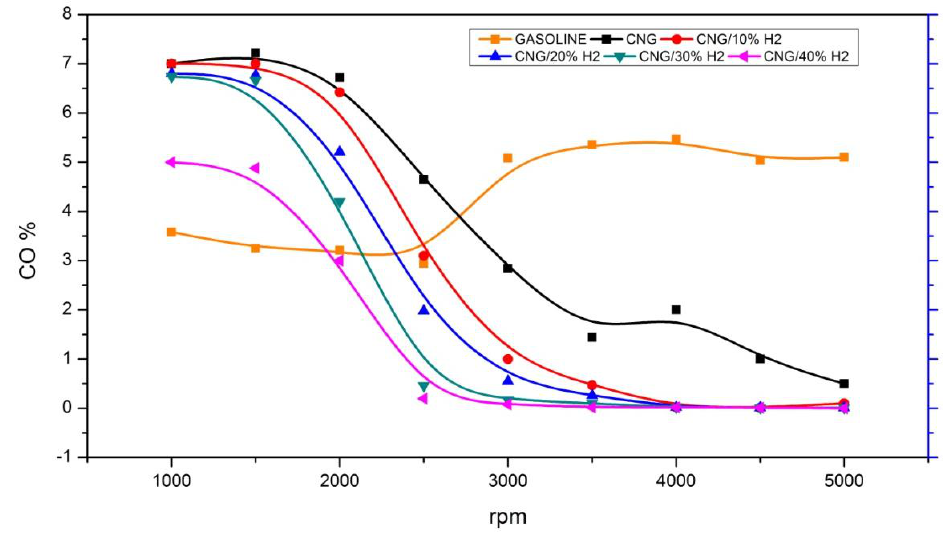
Figure 18. CO concentration in function of engine speed.